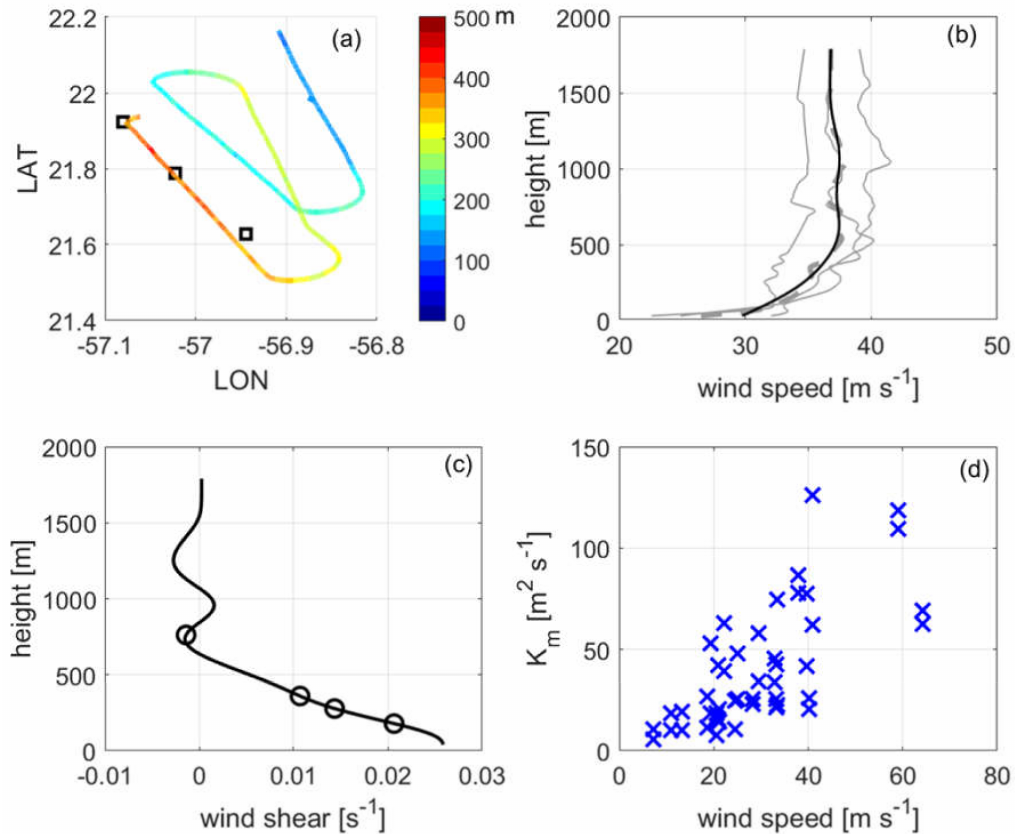
Figure 15. Plots of ( a ) P-3 aircraft (N43) horizontal track varving with altitude in color and dropsonde locations (squares) released by a second P-3 aircraft (N42) flying above N43, ( b ) vertical profiles of wind speed from dropsondes with the mean wind profile (dashed line) and smoothed mean profile (black line), ( c ) vertical profile of the vertical wind shear with low-level aircraft altitudes (circles), and ( d ) vertical eddy diffusivity from a multitude of dropsonde and flight-level gmeasurement locations as a function of wind speed. Reproduced and adapted from